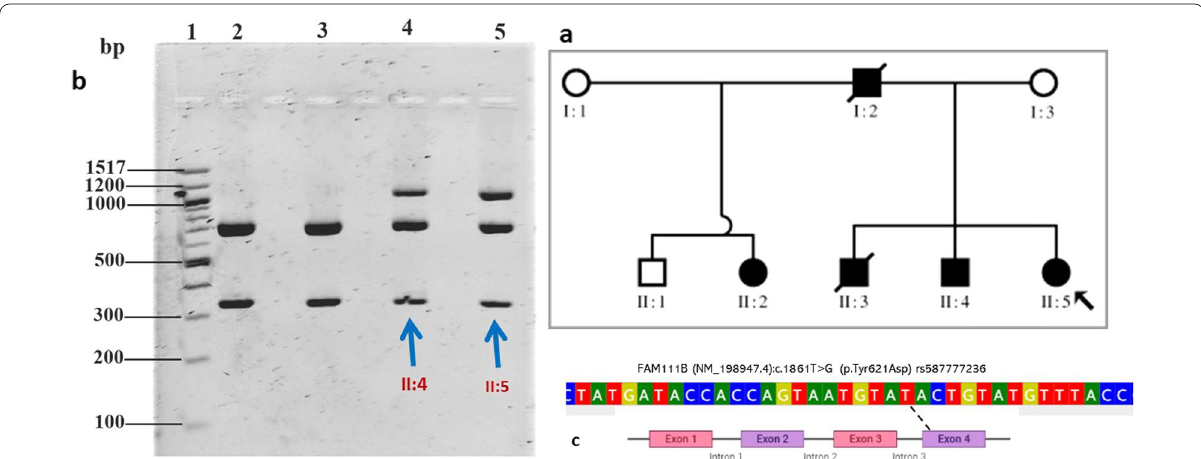
Fig. 1 a PCR–RFLP genotyping of the South Africa family with the FAM111B heterozygous [NM_198947.4: c.1861T>G (p. Tyr621Asp)] gene mutation at exon 4. Lanes 1: 100 bp DNA ladder (NEB, USA), 2: Familiar control (WT i.e., unaffected mother), 3: unrelated control (WT), 4: POIKTMP (mutant) affected family member, 5: a second POIKTMP affected family member. The expected band sizes: WT (i.e., T/T genotype) and heterozygous mutant (i.e., T/G) 1085, 740 and 345 bp. b Pedigree analysis of the family. c The description of the location of the mutation of = interest reported in the